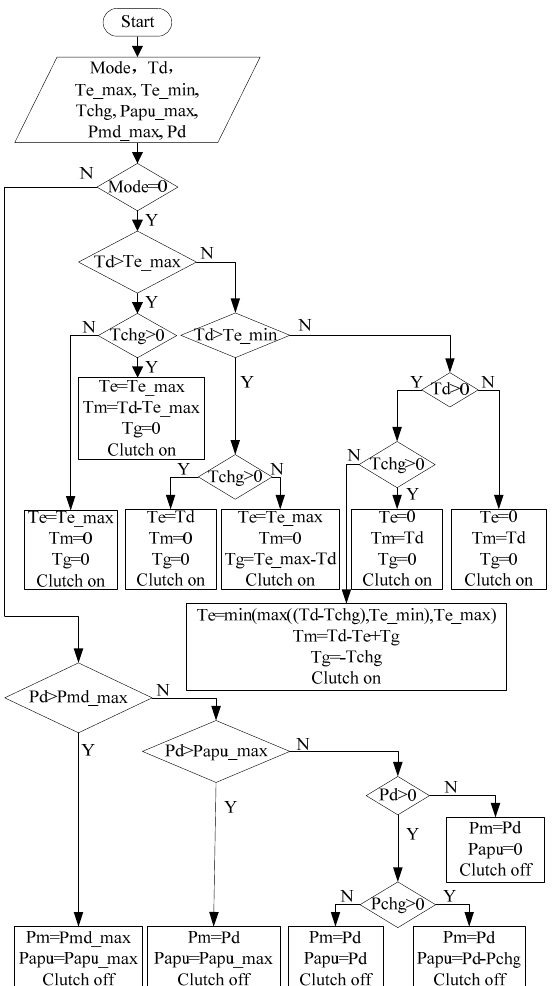
Figure 10. Energy management control strategy in CS